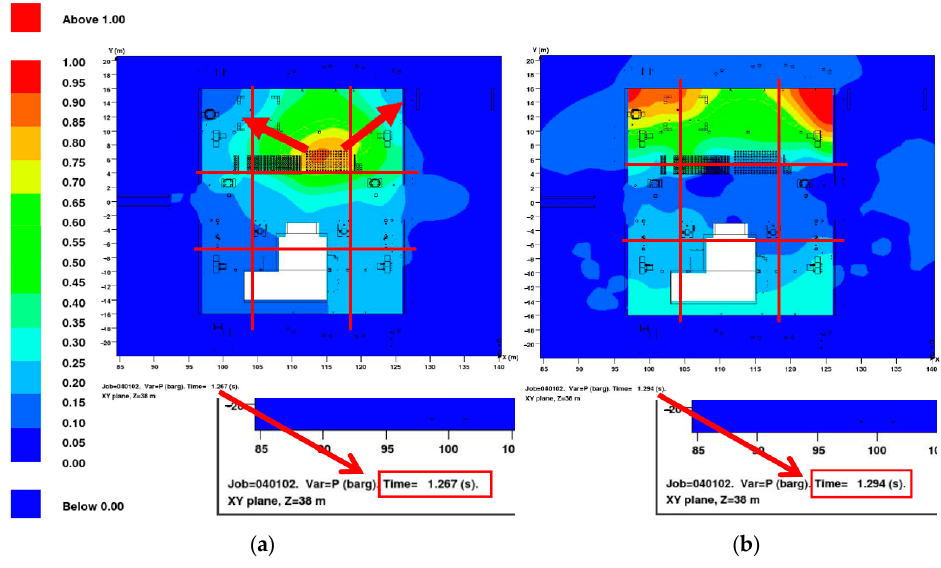
Figure 13. Propagation of blast pressure ( a ) at 1.267 s after ignition, ( b ) at 1.294 s after ignition.